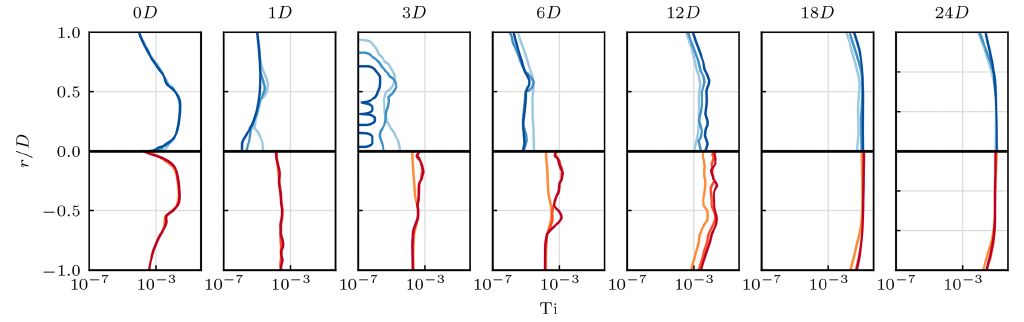
(cid:113) 1 u (cid:48) u (cid:48) of the CLBM compared to the NS reference cases. Please note i i 3 0